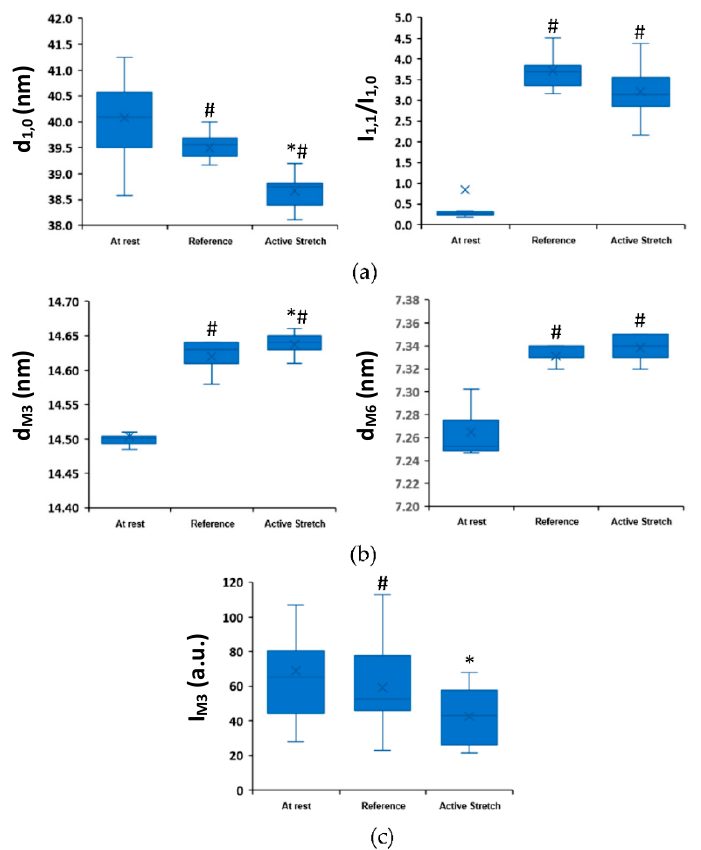
Figure 2. The equatorial and meridional reflections, at an average SL of 3.0 µm, at rest (Rest), and at steady-state isometric contraction following a purely isometric reference contraction (Reference) and an active lengthening contraction (Active Stretch). ( a ) Lattice spacing (d 1,0 ) and the intensity ratio (I 1,1 /I 1,0 ) measured from the equatorial reflections; ( b ) M3 and M6 spacings (d M3 and d M6 ) measured from the meridional reflections; ( c ) M3 intensity (I M3 ) measured from the meridional reflections. *: indicates a significant difference from the reference condition, #: indicates a significant difference from the rest condition. Data ( n = 11 bundles) are shown as box plots, where whiskers show minimum and maximum values, boxes indicate the interquartile range from Q1 to Q3, and the median values are shown (x).